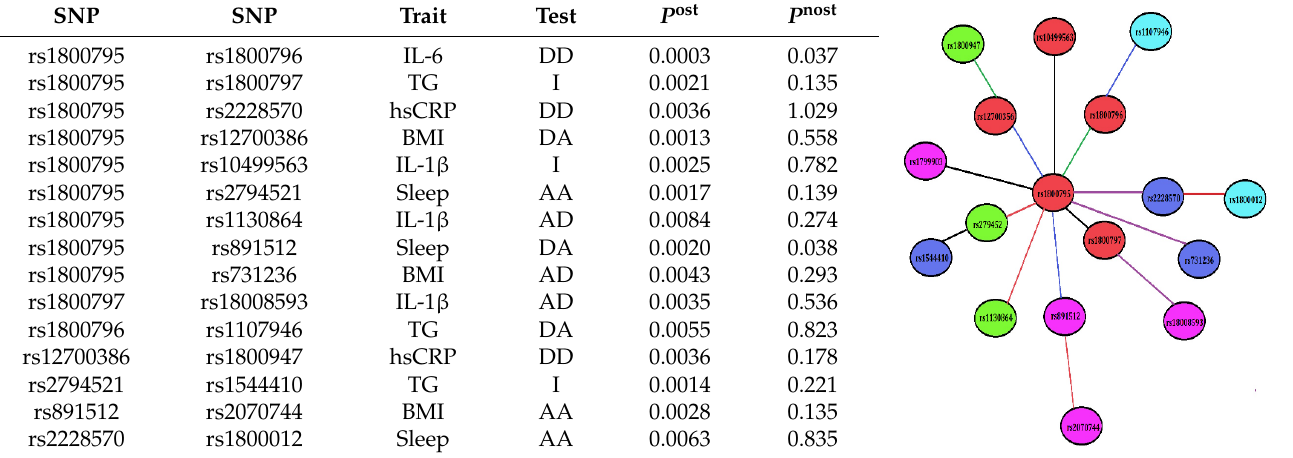
Table 3. Significant SNP–SNP cross talks and epistasis effects amongst CRP, COL1A1, IL-6, VDR, and eNOS genes. SNP SNP Trait SNP